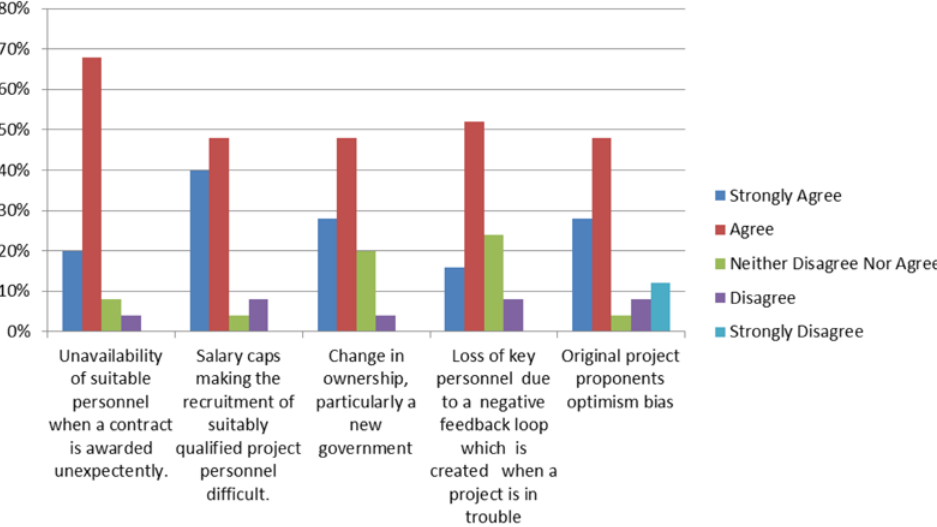
Panel members’ views of the additional problems identified in project